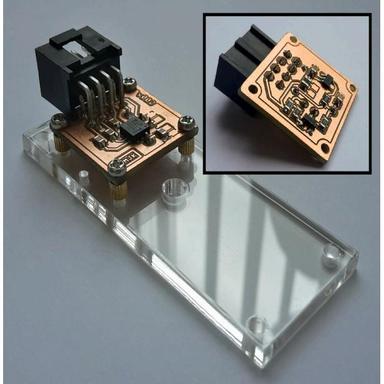
ADXL316 module mounted on acrylic cut sample holder. Inset shows PCB bottom with power supply and filtering circuit. The test sample (DUT) can be placed on the clear spot, opposite to the accelerometer module. Acrylic holder has dimensions of 63 mm long and 25 mm wide and 3 mm thickness. ADXL316 module is double layer square PCB with a 20 mm side. (https://doi.org/10.6084/m9.figshare.12585023) CC BY 4.0 license].